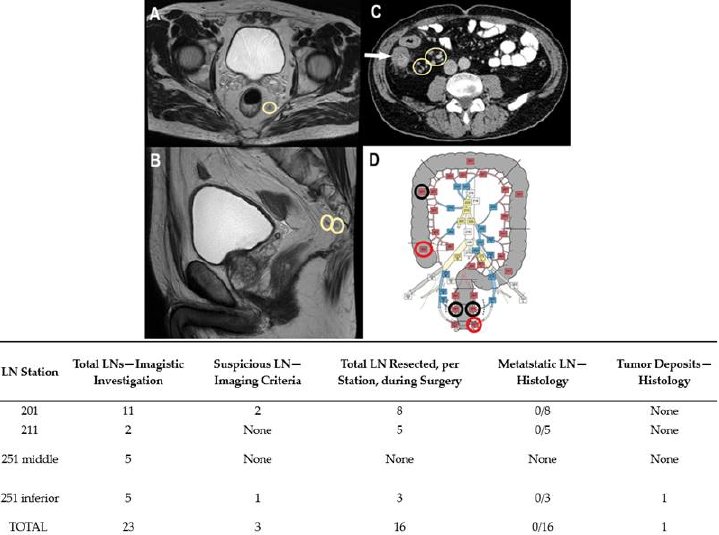
Figure 1. Case No. 1: synchronous cecal and rectal tumor. Circumferential thickening with inhomogenous enhancement and showing infiltration of the mesenteric fat at the level of the caecum (white arrow). Suspected lymph nodes (LNs) are visible on pelvic MRI scan, T2 weigthed FRFSE axial ( A ) and sagital ( B ) view. They are also marked on contrast-enhanced abdominal CT scan, venous phase, axial view ( C ). ( D )—Based on imagistic aspects, the map of nodal stations is edited— adapted with permission from Yamamoto S et al. [14]—black circle—visible LN stations, without suspicious criteria; red circle- suspect LN stations. Table: imagistic-histopathological correlation of node stations. The two suspicious LN in 201 nodal station were negative by pathologic report. The perirectal tumor deposit was imagistically detected as suspected for LN metastasis.